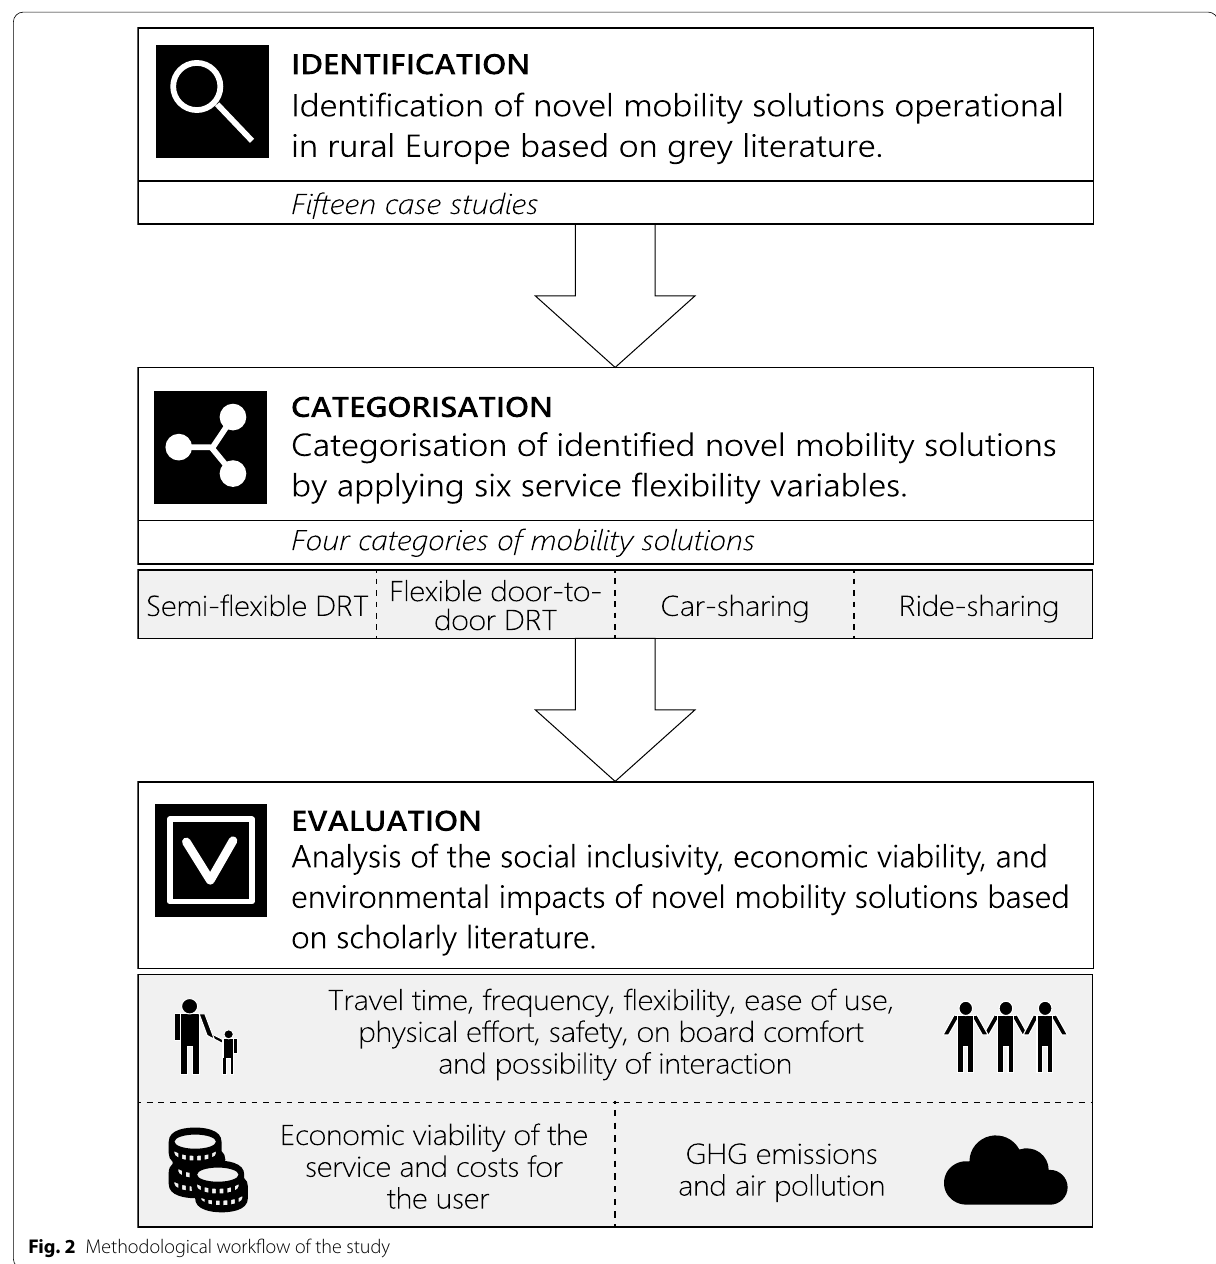
Fig. 2 Methodological workflow of the